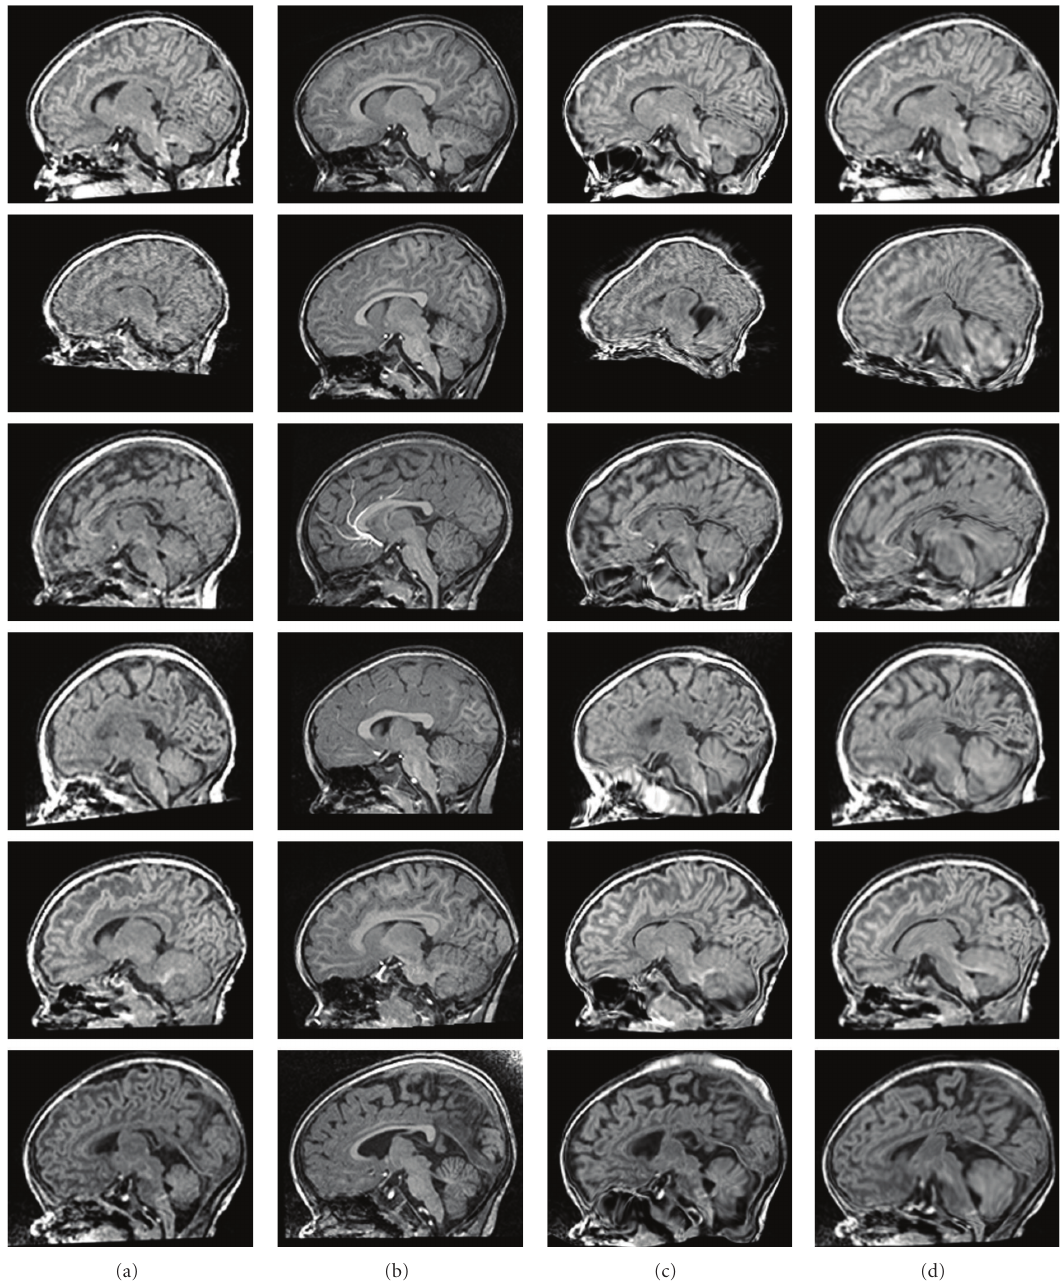
Figure 10: Registration results of neonates mapped to 2-year olds. From left to right: (a) neonatal T1 image after a ffi ne registration, (b) reference T1 image at 2 years, followed by (c) neonatal T1 after deformable mutual information registration using B-splines, and (d) after combined probabilistic and geometric registration. From top to bottom: subjects 0012, 0102, 0106, 0121, 0130, and 0146. We note that the initial a ffi ne registration for subject 0102 (second row, second column) is incorrect; however our method managed to compensate and generate improved result compared to deformable mutual information